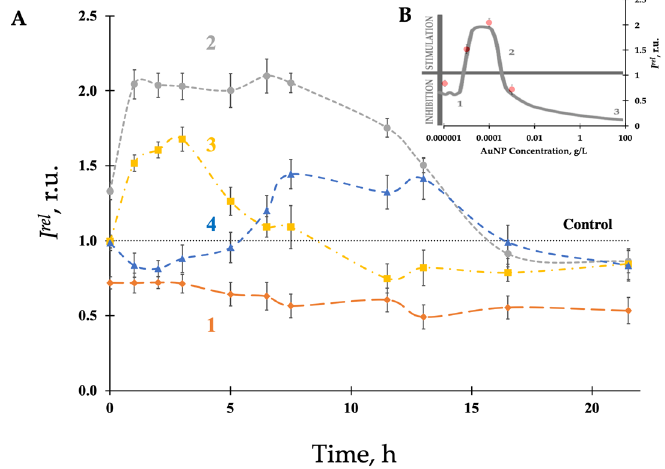
Figure 1. Bioluminescence intensity of bacteria, I rel , sampled at stationary growth phase (24 h). ( A ) Bioluminescence kinetics after exposure to AuNPs of different concentrations (color curves) : 10 − 3 g/L ( 1 ), 10 − 4 g/L ( 2 ), 10 − 5 g/L ( 3 ), and 10 − 6 g/L ( 4 ); ( B ) Bioluminescence intensity, I rel , at different concentrations of AuNPs (red points), 3-h exposure. Hormetic curve (gray color) is presented according to descriptions presented in [46]. Three stages of hormesis include: (1) stress recognition, (2) physiological activation, (3) inhibition of vital